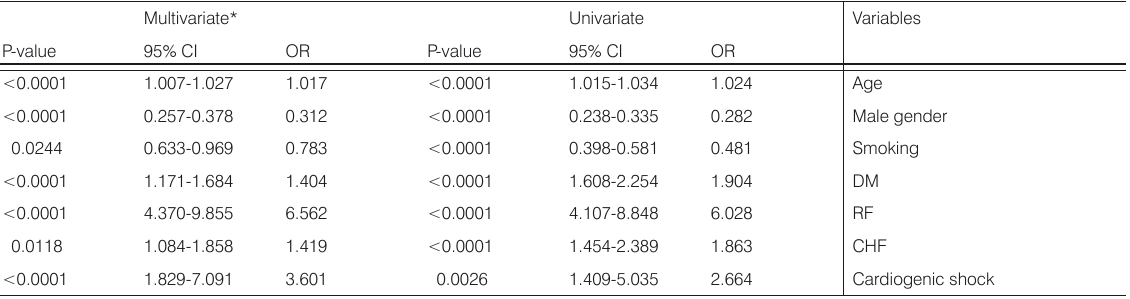
Table 2. Factors associated with Hgb less than 12 g/dl in patients underwent isolated